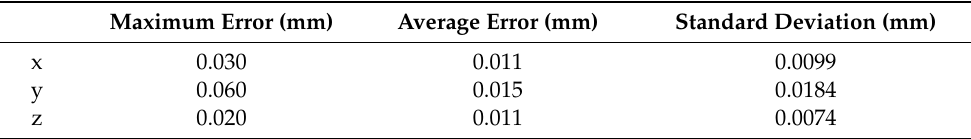
Table 7. Evaluation of Position